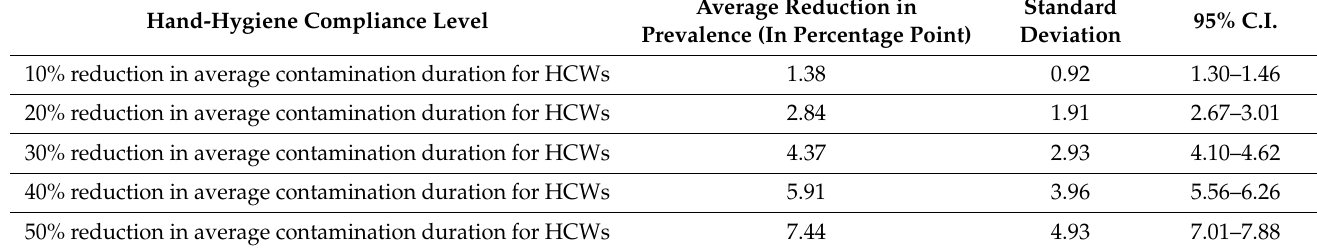
Table 1. Effect of five levels of hand-hygiene compliance to Methicillin-Resistant Staphylococcus aureus (MRSA) coloniza- tion